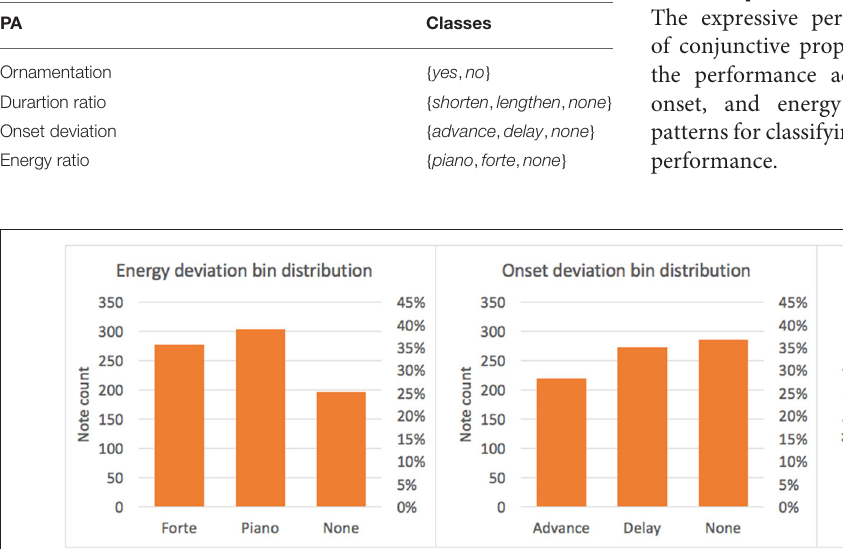
TABLE 5 | Expressive performance actions.